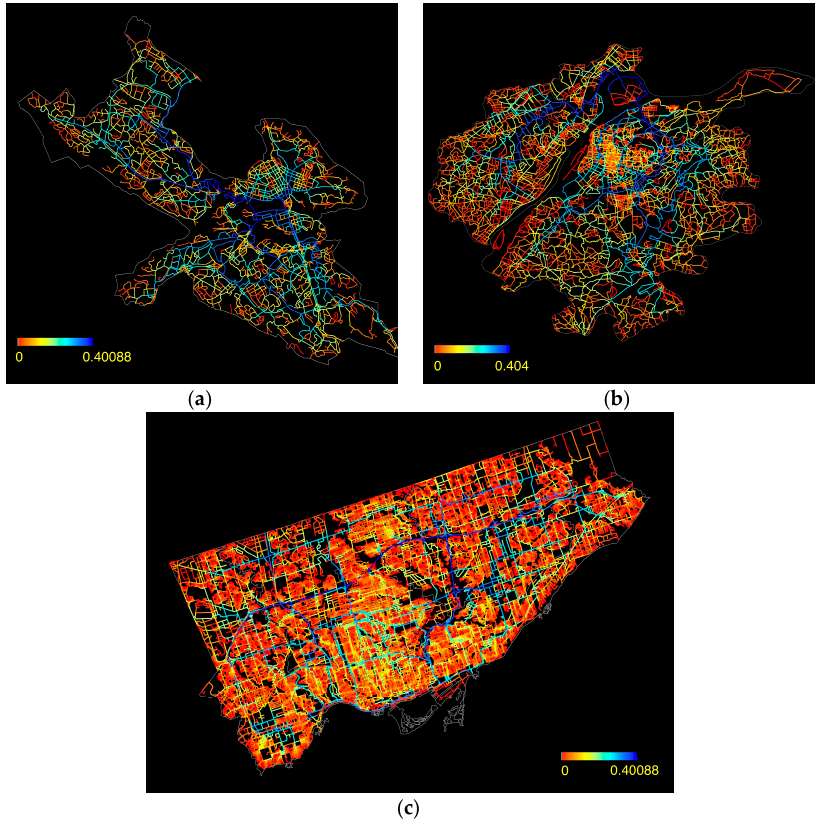
Figure 8. Betweenness distributions of the urban street systems of ( a ) Stockholm; ( b ) Nanjing, and ( c ) Toronto (the values of betweenness centrality are divided into 32 classes from the minimum to the maximum, corresponding to the color from red to blue).